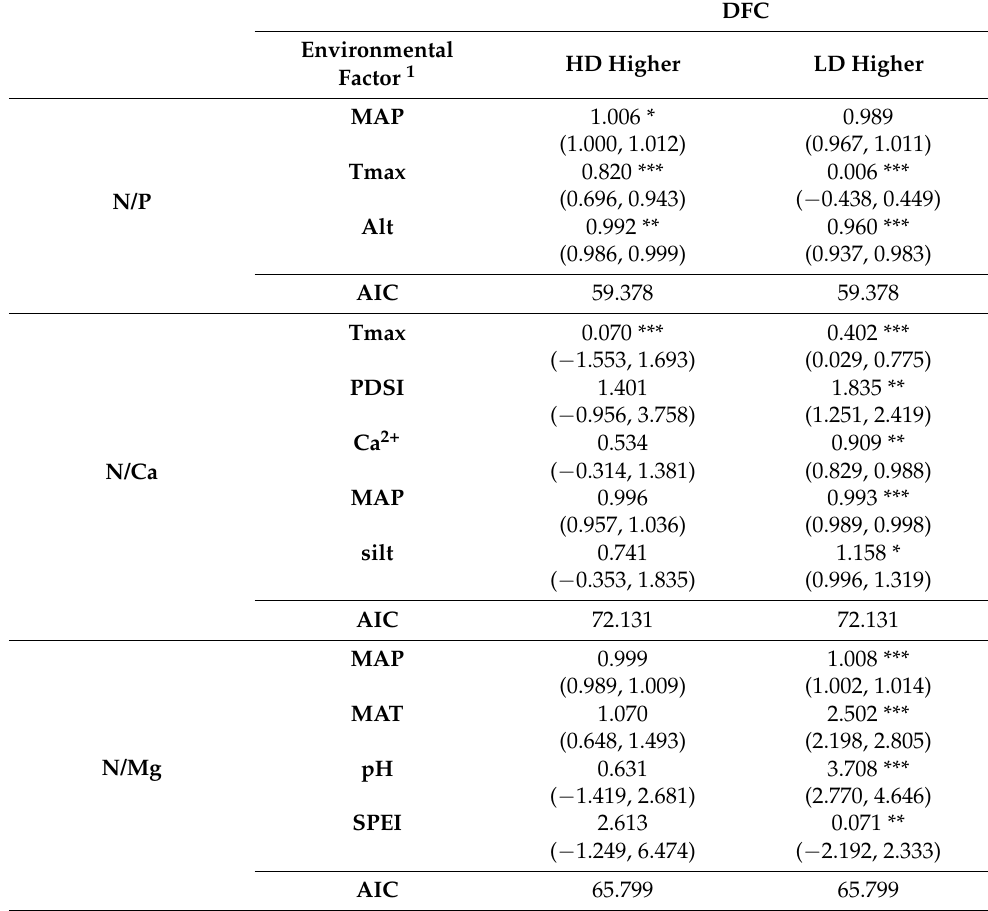
Table 6. Results of multinomial logistic regression for Differences in Foliar Ratios (DFR) of potassium, calcium and magnesium. Odds ratios are reported for each environmental factor while the confidence intervals are given in the brackets (* p < 0.1, ** p < 0.05, *** p < 0.01). DFC Environmental HD Higher LD Higher Factor 1 MAP 1.006 * 0.989 (1.000, 1.012) (0.967, 1.011) Tmax 0.820 *** 0.006 *** (0.696, 0.943) ( − 0.438, 0.449) N/P Alt 0.992 ** 0.960